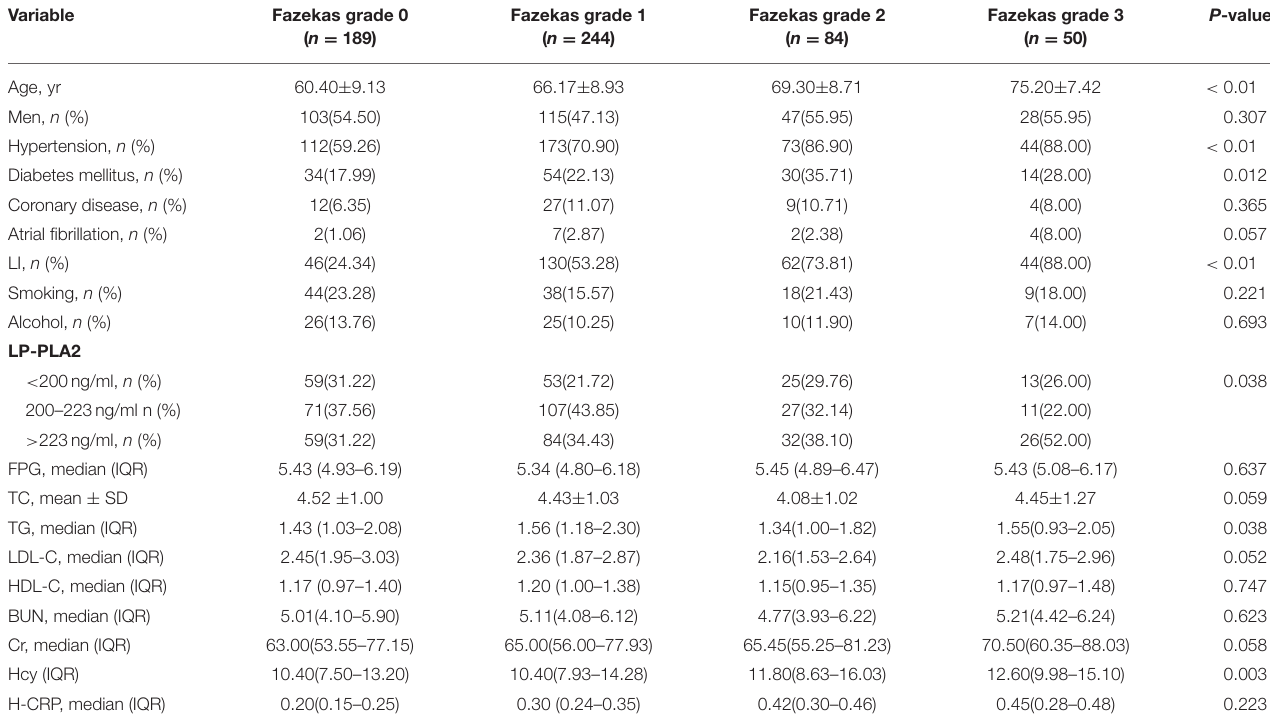
TABLE 3 | Clinical characteristics of subjects with DSWMH.